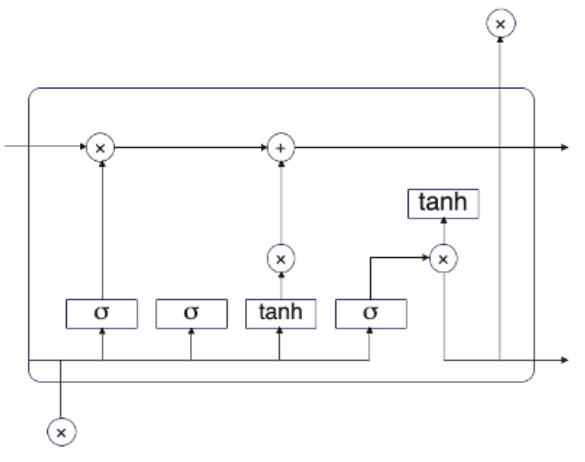
Figure 4. LSTM cell structure